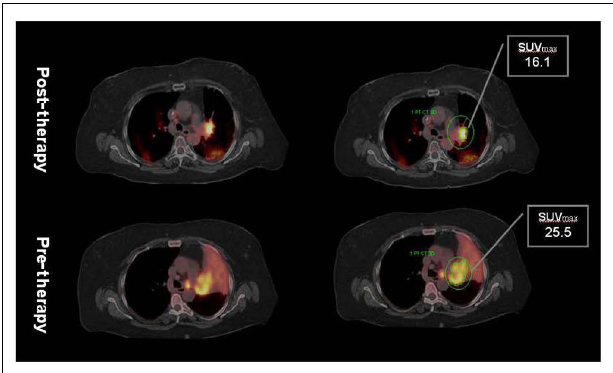
FIGURE 3 | Post-radiation therapy F18 FDG PET/CT shows significant decrease in tumor volume but as well as SUVmax. However, considerable amount of metabolically active residual tumor is evident in post-therapy PET suggesting inadequate local control. Note absence of atelectasis with reinflation of the lung secondary to decrease in tumor volume. Minor post-radiation inflammatory changes in the posterior lung are characterized by mild increased FDG uptake. Data courtesy of M. D. Anderson, Cancer Center, Orlando, FL, USA.